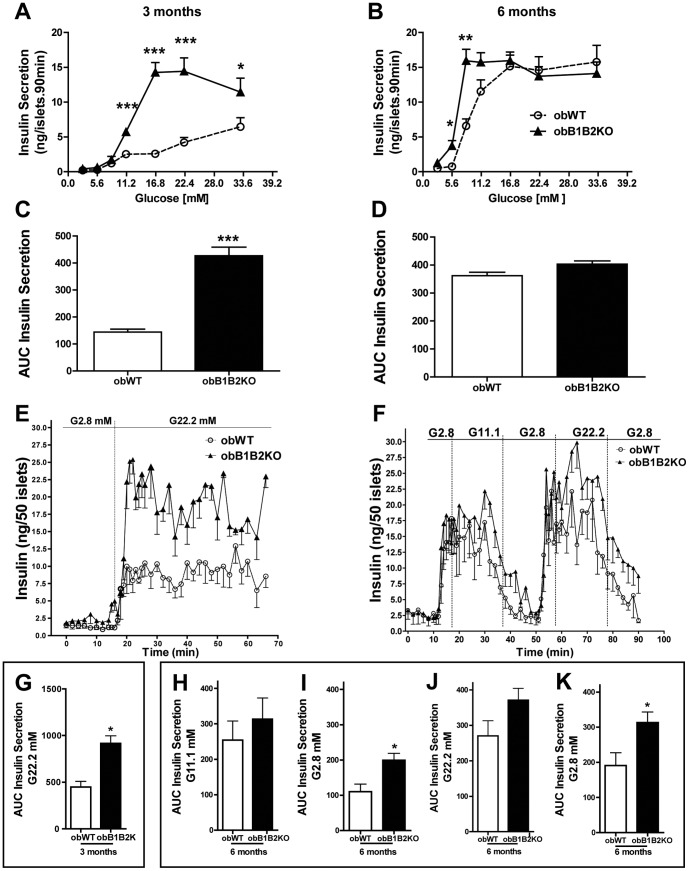
Islets from obB1B2KO mice release more insulin.Insulin secretion and analysis of pancreatic islets from 3-month-old (A and C) and 6-month-old mice (B and D) when exposed to medium containing various concentrations of glucose (EC50 = 16.97+/−0.352 and 11.30+/−0.196; for 3-month-old obWT and obB1B2KO respectively (average +/− SD) and 8.41+/−0.217 and 6.29+/−0.651 for 6-month-old mice); E and G) Dynamic analysis of insulin secretion from islets of 3-month-old mice; F and H to K) Dynamic analyzes of insulin secretion from islets from 6-month-old mice. K and I) Analysis showing extended recovery time of basal insulin secretion levels from islets of obB1B2KO mice. Data present means ± SEM. *, p<0.05; n = 8×5 islets for static analyzes and n = 4×50 islets for dynamic analyzes.